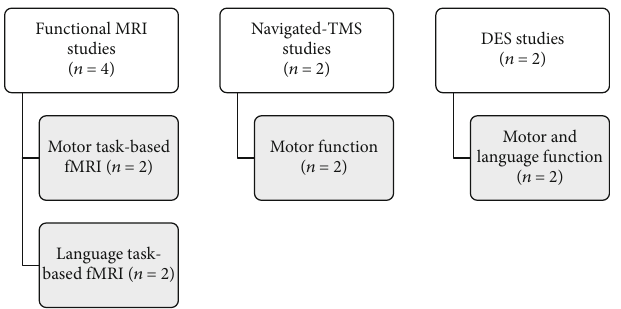
Figure 2: Summary of the included studies depending on the mapping